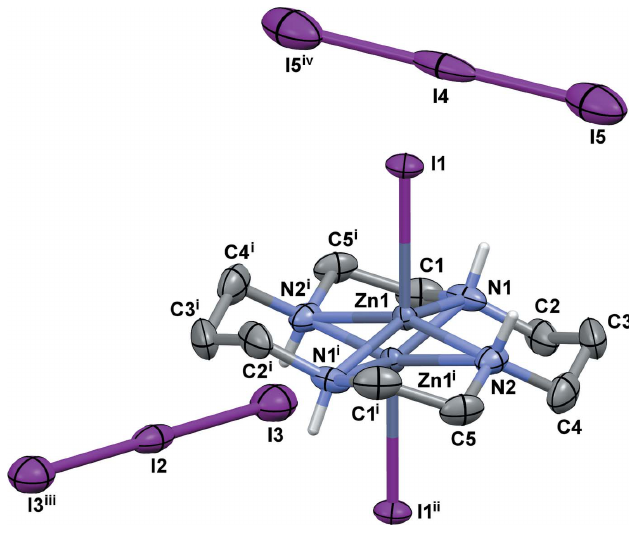
Figure 1 View of the molecular structure of I showing the atom-labeling scheme with displacement ellipsoids drawn at the 30% probability level. C-bound H atoms are omitted for clarity. Hydrogen-bonding interactions are shown as dashed lines.